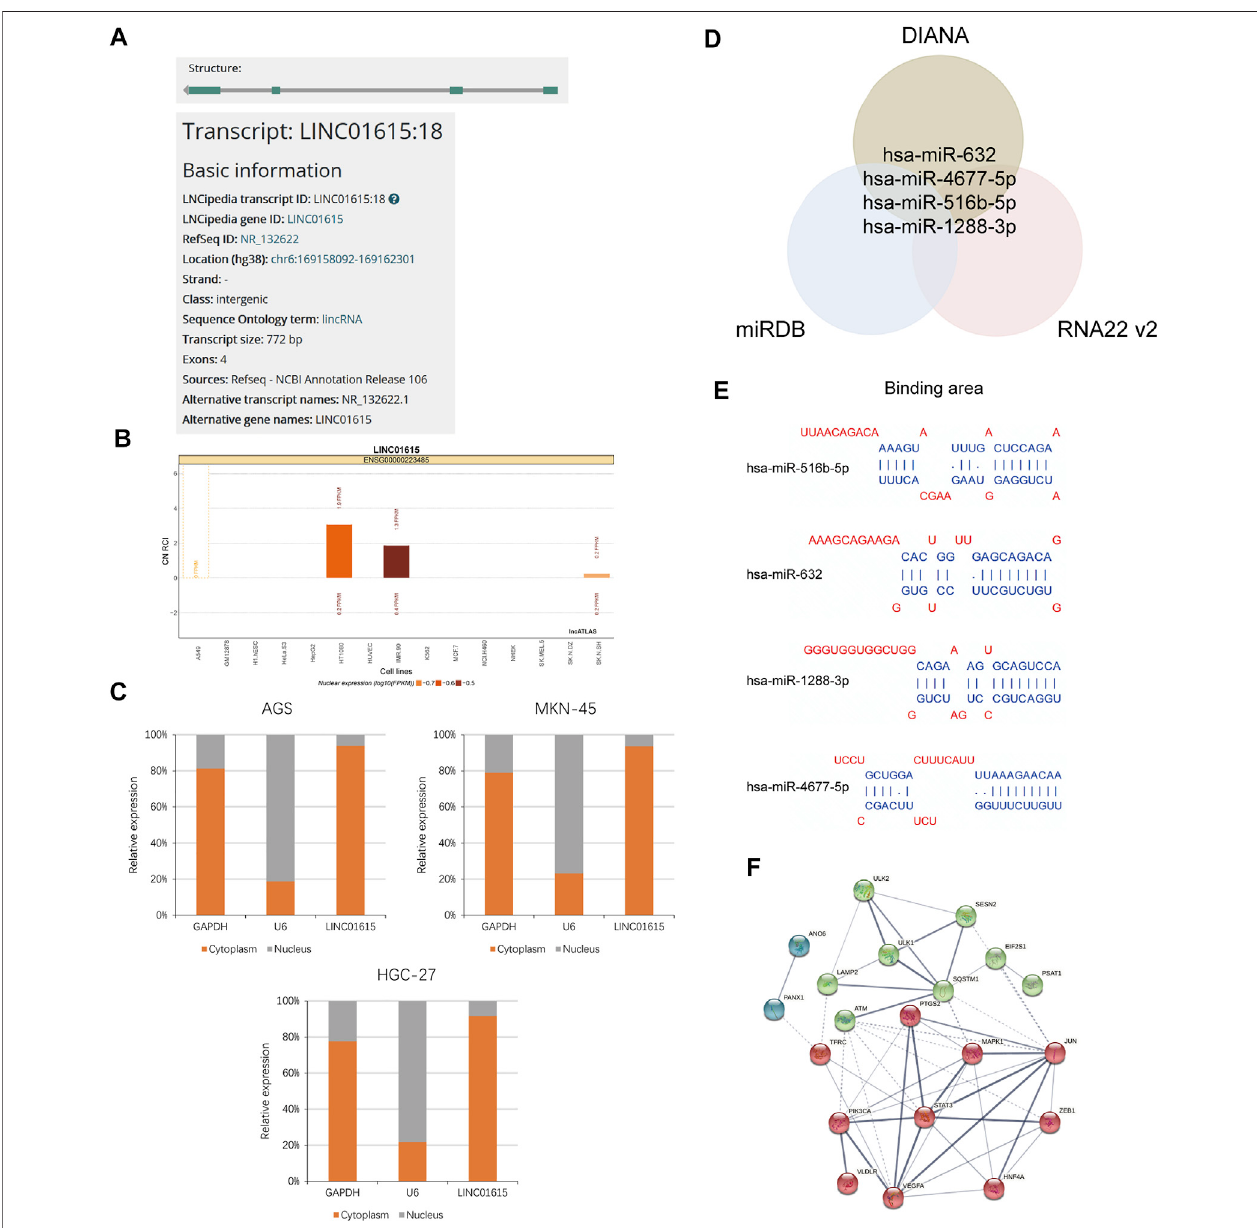
FIGURE 7 | LINC01615 acted as a molecular sponge for miRNA in STAD. (A) Information about LINC01615 in LNCipedia. (B) Subcellular localization for LINC01615 in lncATLAS. (C) Subcellular fraction assay. (D) Potential miRNA targets for LINC01615. Intersection of the results from DIANA, miRDB, and RNA22 V2 prediction. (E) Depiction of the binding sequences of 4 miRNAs on LINC01615. (F) PPI network for 20 mRNAs related to ferroptosis with kmeans